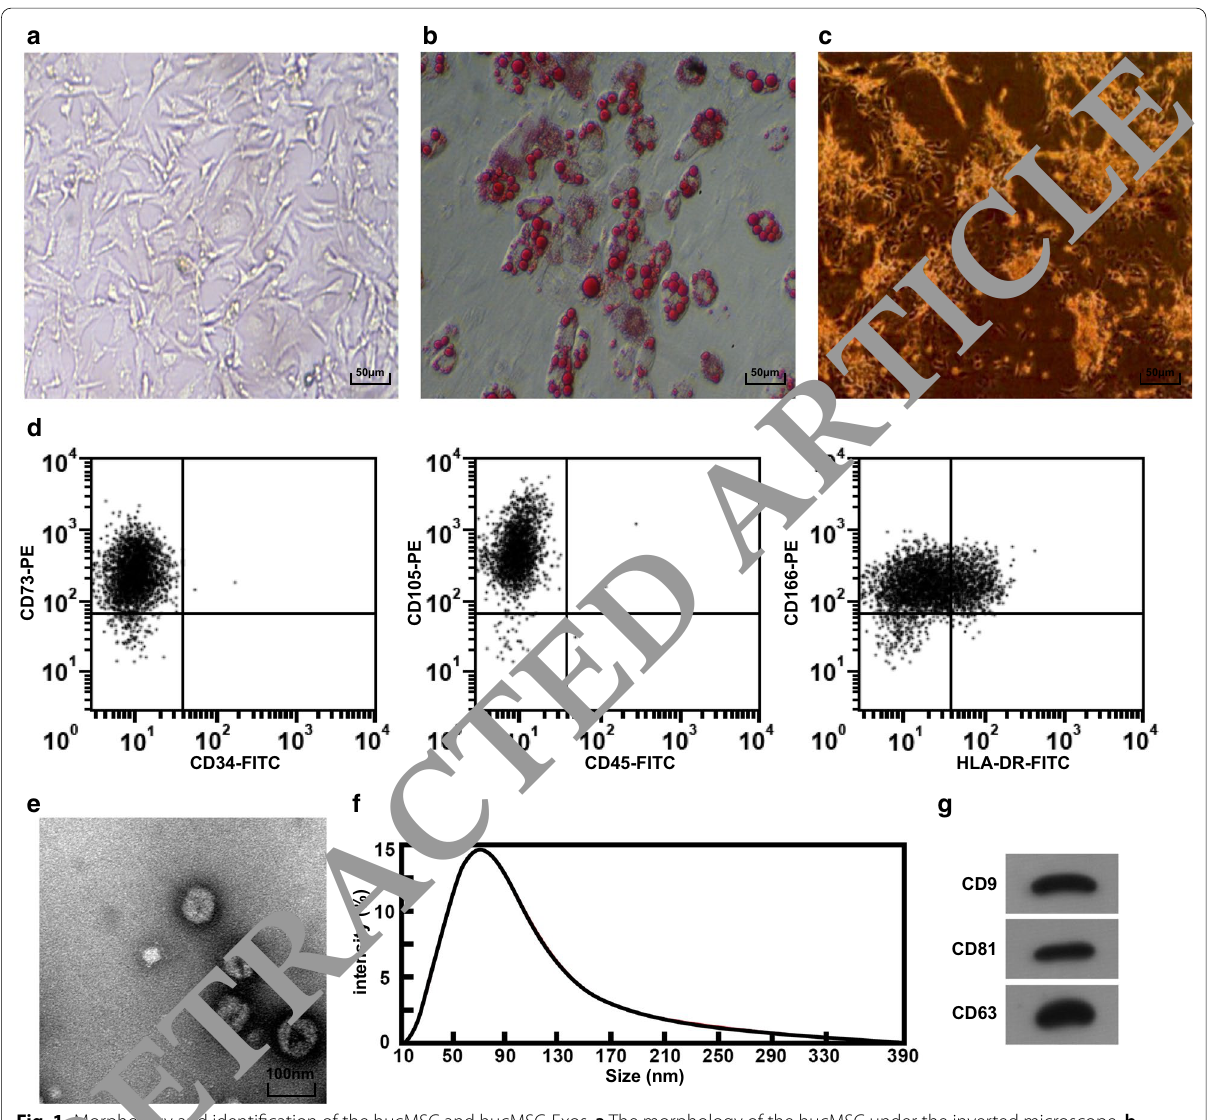
Fig. 1 Morphology and identification of the hucMSC and hucMSC-Exos. a The morphology of the hucMSC under the inverted microscope, b hucMSC was tested by oil red O staining. c hucMSC was tested by ALP staining. d Flow cytometry was used to detect immunophenotype. e The shape and size of hucMSC-Exos observed through a TEM. f Detection of particle size distribution of exosomes using Nanosight analysis. g Protein expression of CD9, CD81 and CD63 in hucMSC-Exos was detected by western blot assay apoptotic cells, which were reduced by miR-18b-3p ele- some villi were performed fibrinoid necrosis, and the number of syncytiotrophoblast nodules in placental vation and LEP silencing, and were further enhanced by villi increased, and most of the villi were immature. The miR-18b-3p inhibition; LEP silencing also reversed the number of trophocytes was reduced, and the pathologi- effect of miR-18b-3p inhibition on the number of apop- cal changes were alleviated in PE rats treated with miR- totic cells in PE rats (Fig. 3b, c). 18b-3p agomir and si-LEP (Fig. 3a). Taken together, rats with upregulated miR-18b-3p or TUNEL staining suggested that a small number of inhibited LEP had a decreased degree of PE progression apoptotic cells could be seen. PE rats had increased in histology, and silenced LEP could abolish the thera- peutic effect of inhibited miR-18b-3p.